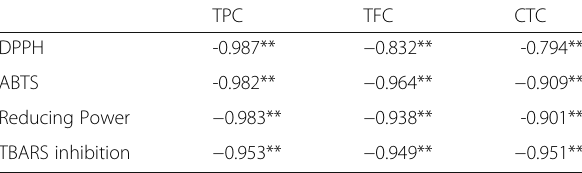
Table 2 Pearson ’ correlation analysis between the antioxidant activity and phytochemical composition of both common date palm